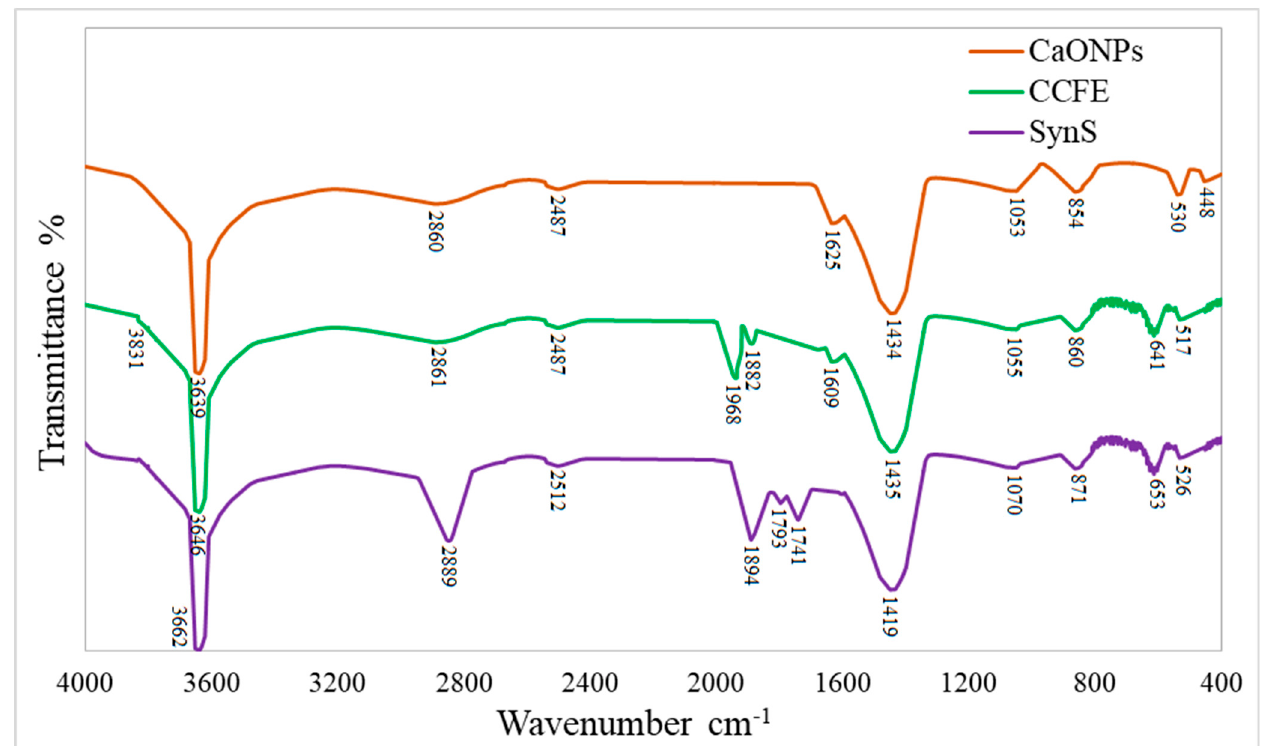
Figure 4. The Fourier-transform infrared (FTIR) spectra of calcium oxide nanoparticles. CaONPs— calcium oxide nanoparticles; CCFE— C. colocynthis fruit extracts, SynS—synergistic solution of CaONPs and CCFE.